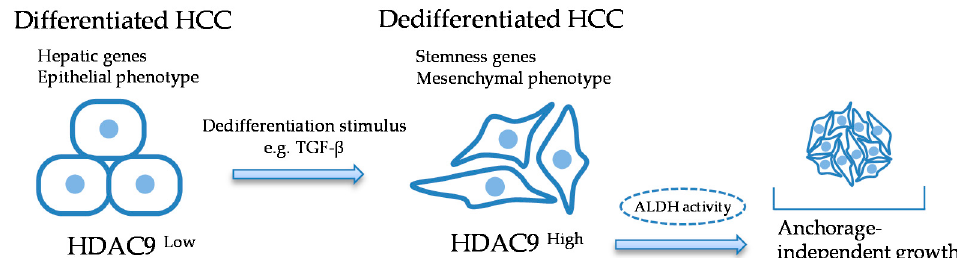
Figure 6. Schematic view of the study. HDAC9 is preferentially expressed in dedifferentiated HCC cells and is involved in an anchorage-independent growth. A broken line indicates the hypothesis needing to be clarified in the future study.